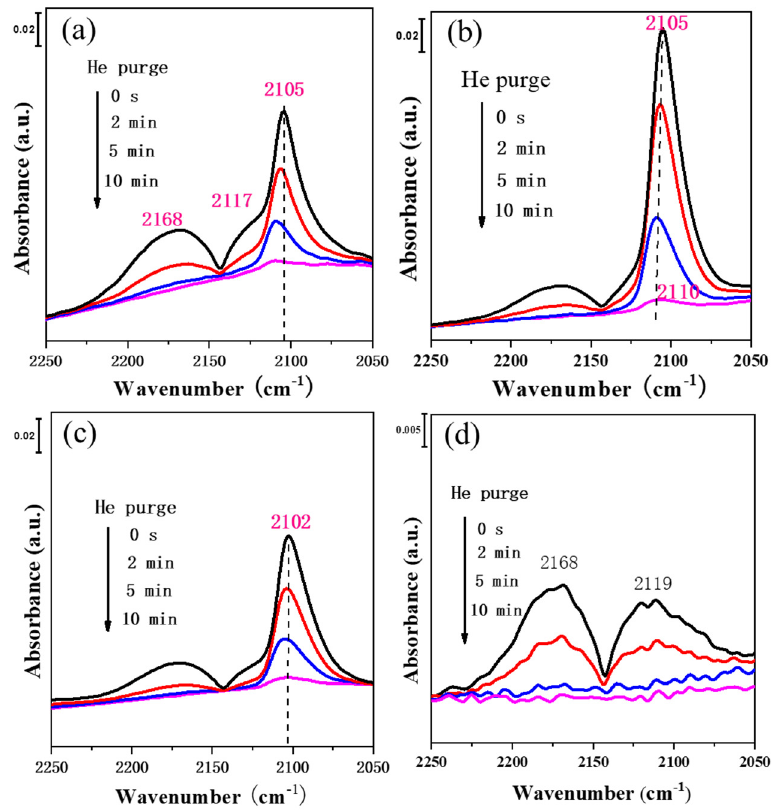
Figure 4. In situ diffuse reflectance infrared Fourier − transform spectroscopy of CO adsorption (CO − DRIFT) spectra of supported gold catalysts: ( a ) Au 25 /Zn 3 Al-400; ( b ) Au 25 /Zn 2 Al-400; ( c ) Au 25 /Zn 1 Al-400; ( d ) Au/Zn 2 Al-400 (DP). The valence state of gold was also provided by X-ray photoelectron spectra (XPS).